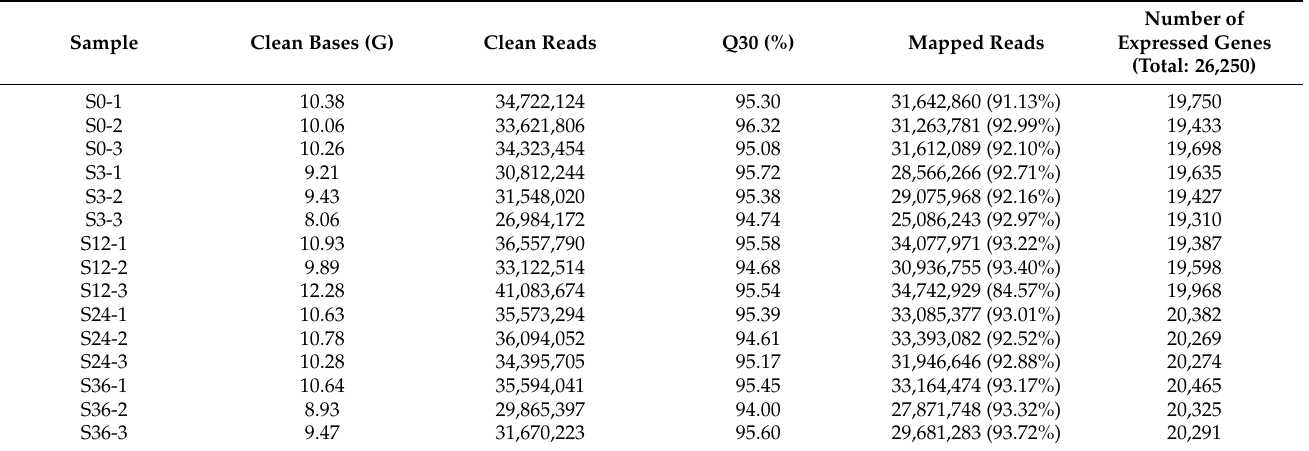
Table 1. Summary of the SCSC transcriptome data.